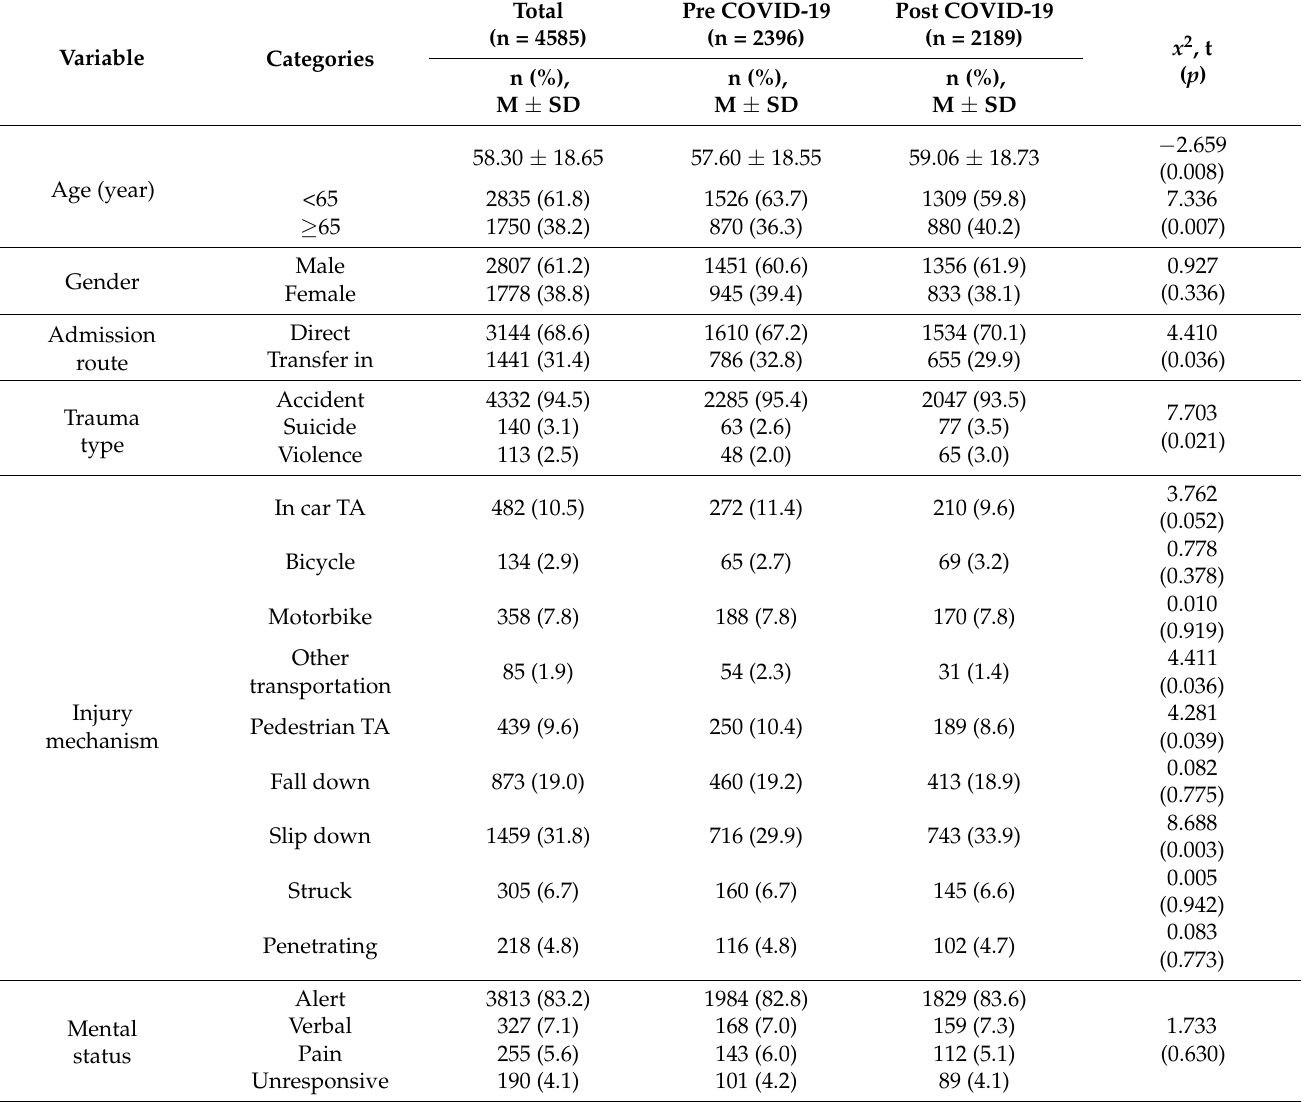
Table 1. Difference between Groups according to General and Clinical